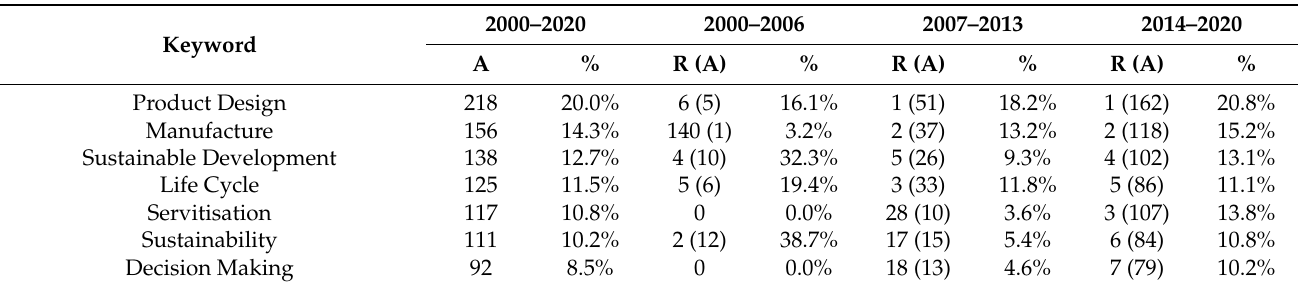
Table 11. Main keywords from 2000 to